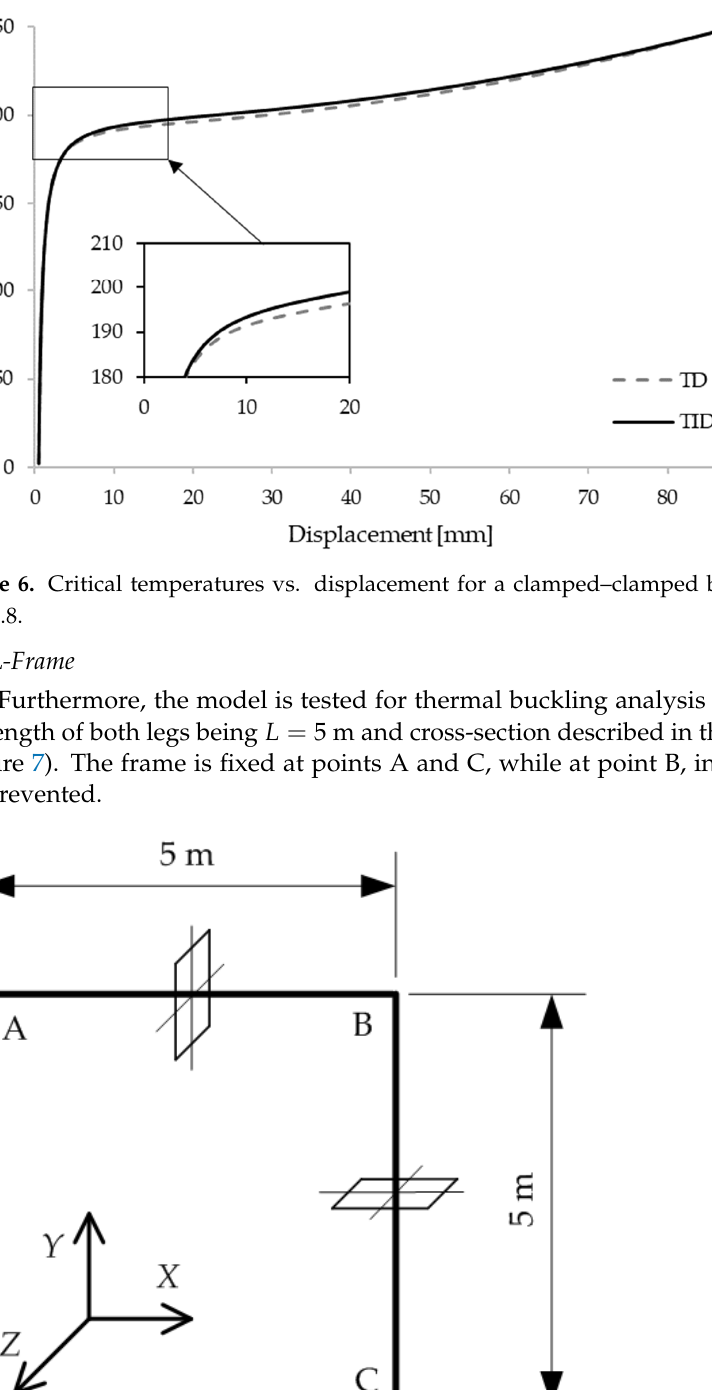
Figure 5. Critical temperatures vs. displacement for a clamped–clamped beam 𝐿 (cid:2869) = 6 m with 𝜆 = 0.5 .